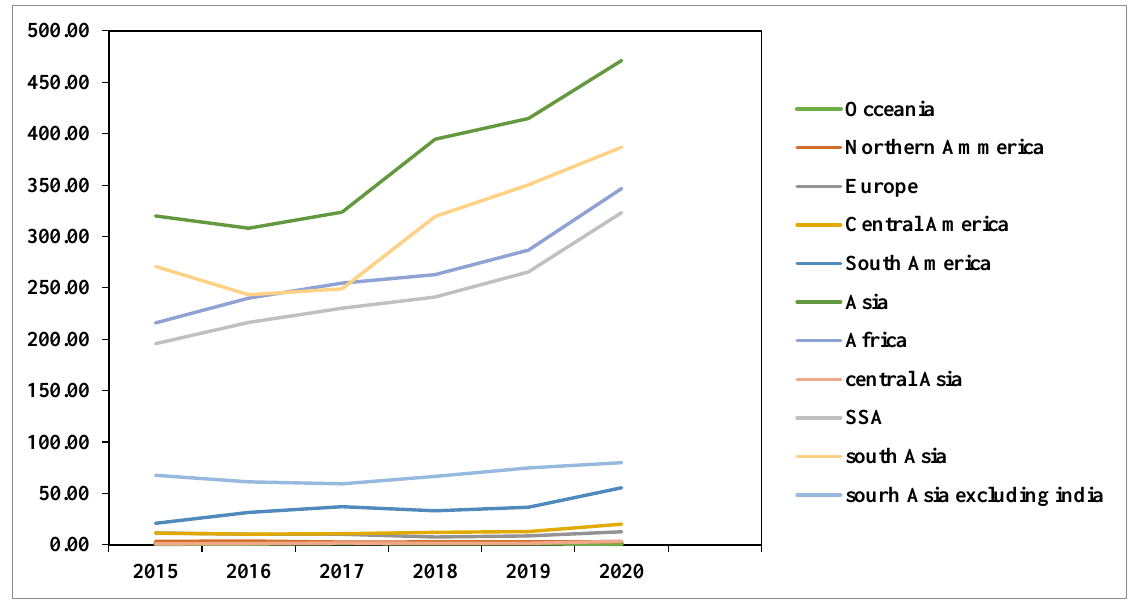
Figure 4. Number of severely food insecure people (in millions) by region from 2014 to 2020. Source: [48].